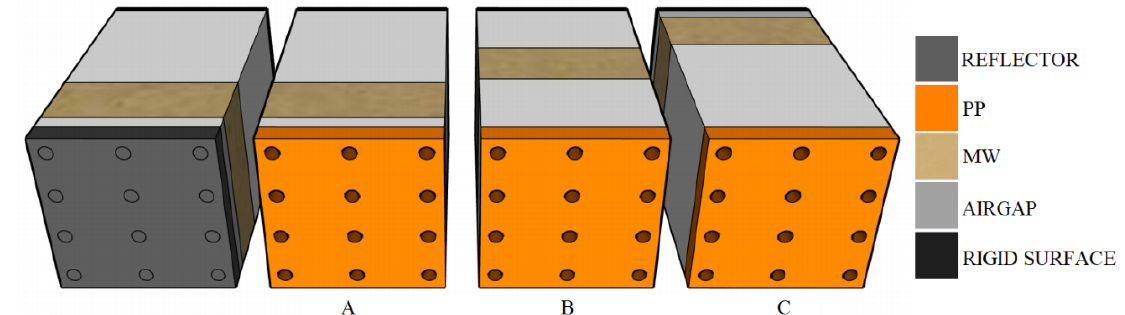
Figure 1. Possible configurations of the variable acoustic solution (acronyms: PP—perforated panel; MW—mineral wool; R—reflective configuration); ( A ) configuration with mineral wool placed near the perforated panel; ( B ) configuration with mineral wool placed in the center of the air gap; ( C ) configuration with mineral wool placed near the back surface.